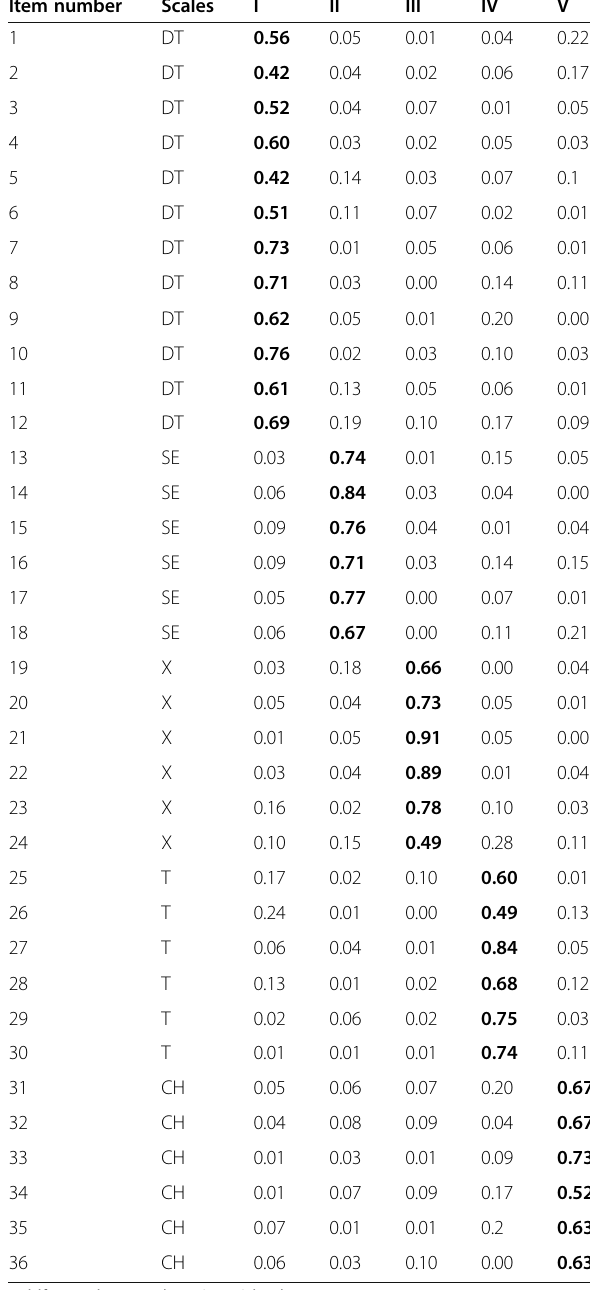
Table 3 Exploratory factor analysis and factor loadings of the SCC-Arabic Item